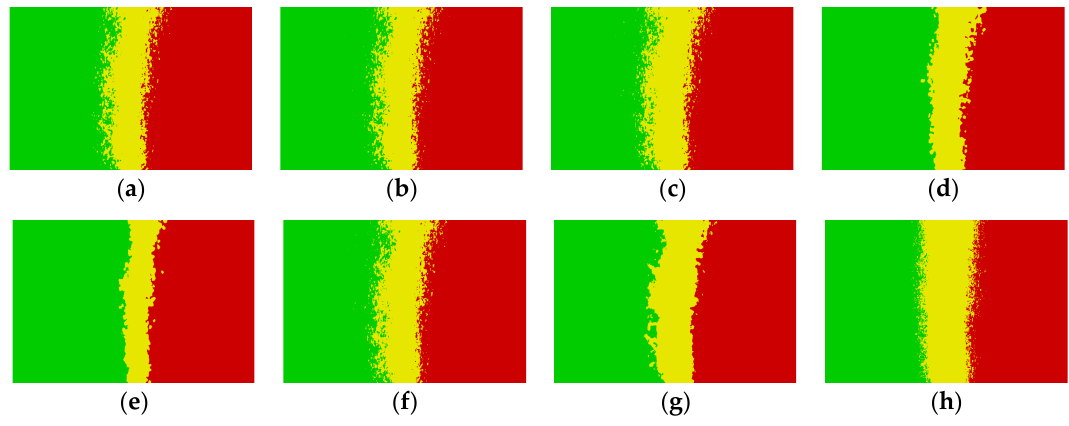
FCM_S1 result, ( b ) FCM_S2 result, ( c ) FGFCM result, ( d ) FLICM result, ( e ) KWFLICM result, ( f ) FCM_SNLS